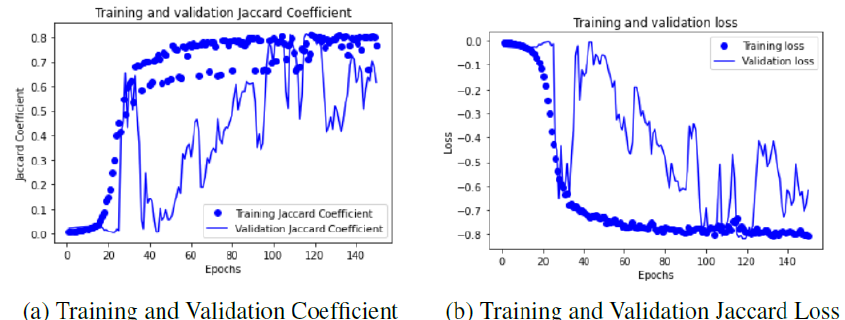
Figure A8. JL training and validation curves after 50 epochs.